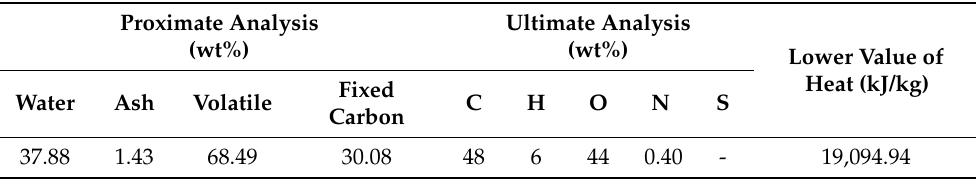
Table 1. Ultimate and proximate analysis of Acacia Nilotica Wood